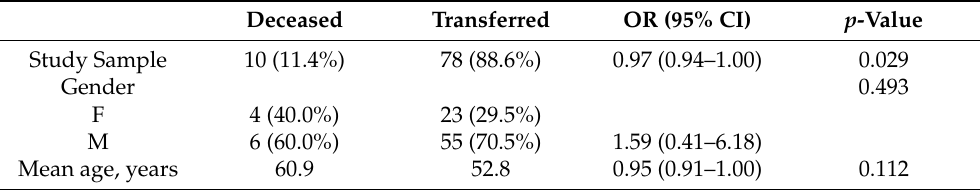
Table 1. Deceased and transferred COVID-19 ICU patients stratified by gender and age.